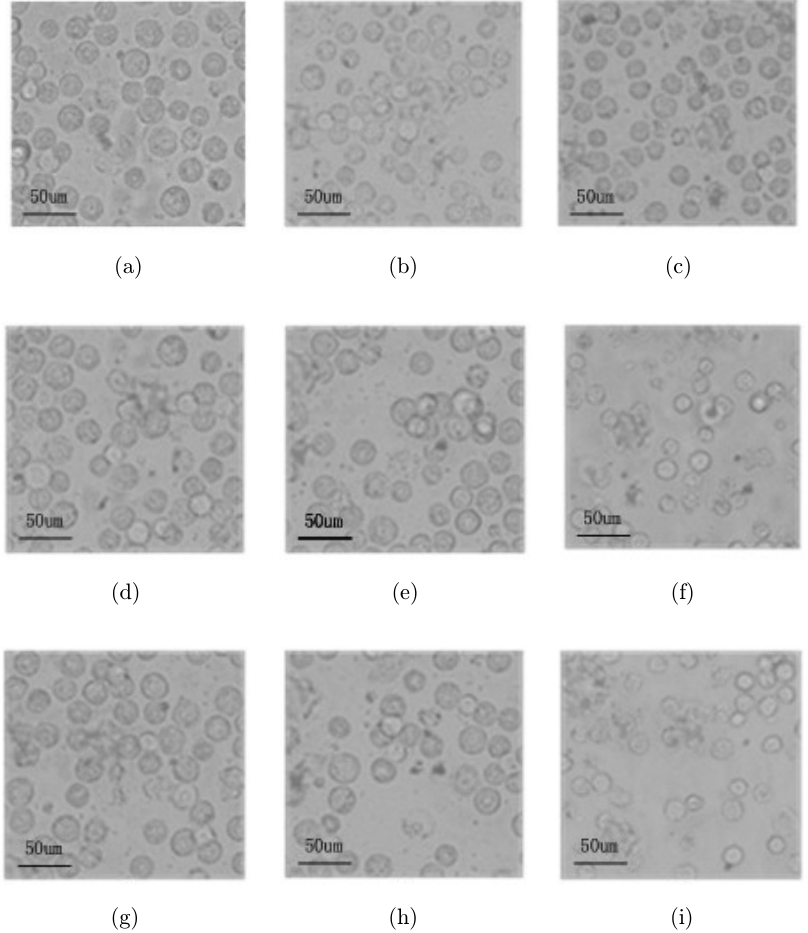
Fig. 5. Photomicrographs of cells after treatment under di®erent LFAMF irradiation ( (cid:3) 400): (a) control group 1, (b) control group 2, (c) control group 3, (d) at 10 mT and 10Hz (e) at 100 mT and 10 Hz (f) at 200 mT and 10 Hz, (g) at 10 mT and 100 Hz (h) at 100 mT and 100 Hz (i) at 200 mT and 100